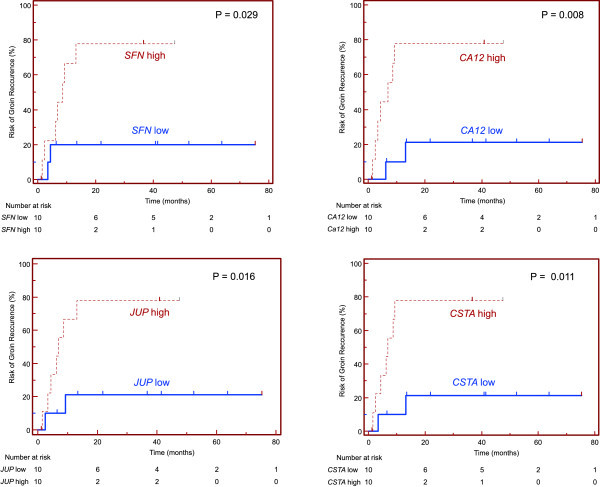
Kaplan-Meier estimates of TTR according toSFN,CA12 JUPandCSTAexpression status (highvslow) in regional LNs. Abbreviations: P – P value calculated using the Mantel-Cox log-rank test; high - expression level, i.e. above the cut-off value; low - expression level, i.e. below the cut-off value (i.e. the median of maximum gene expression levels - as measured in one node per VC patient.